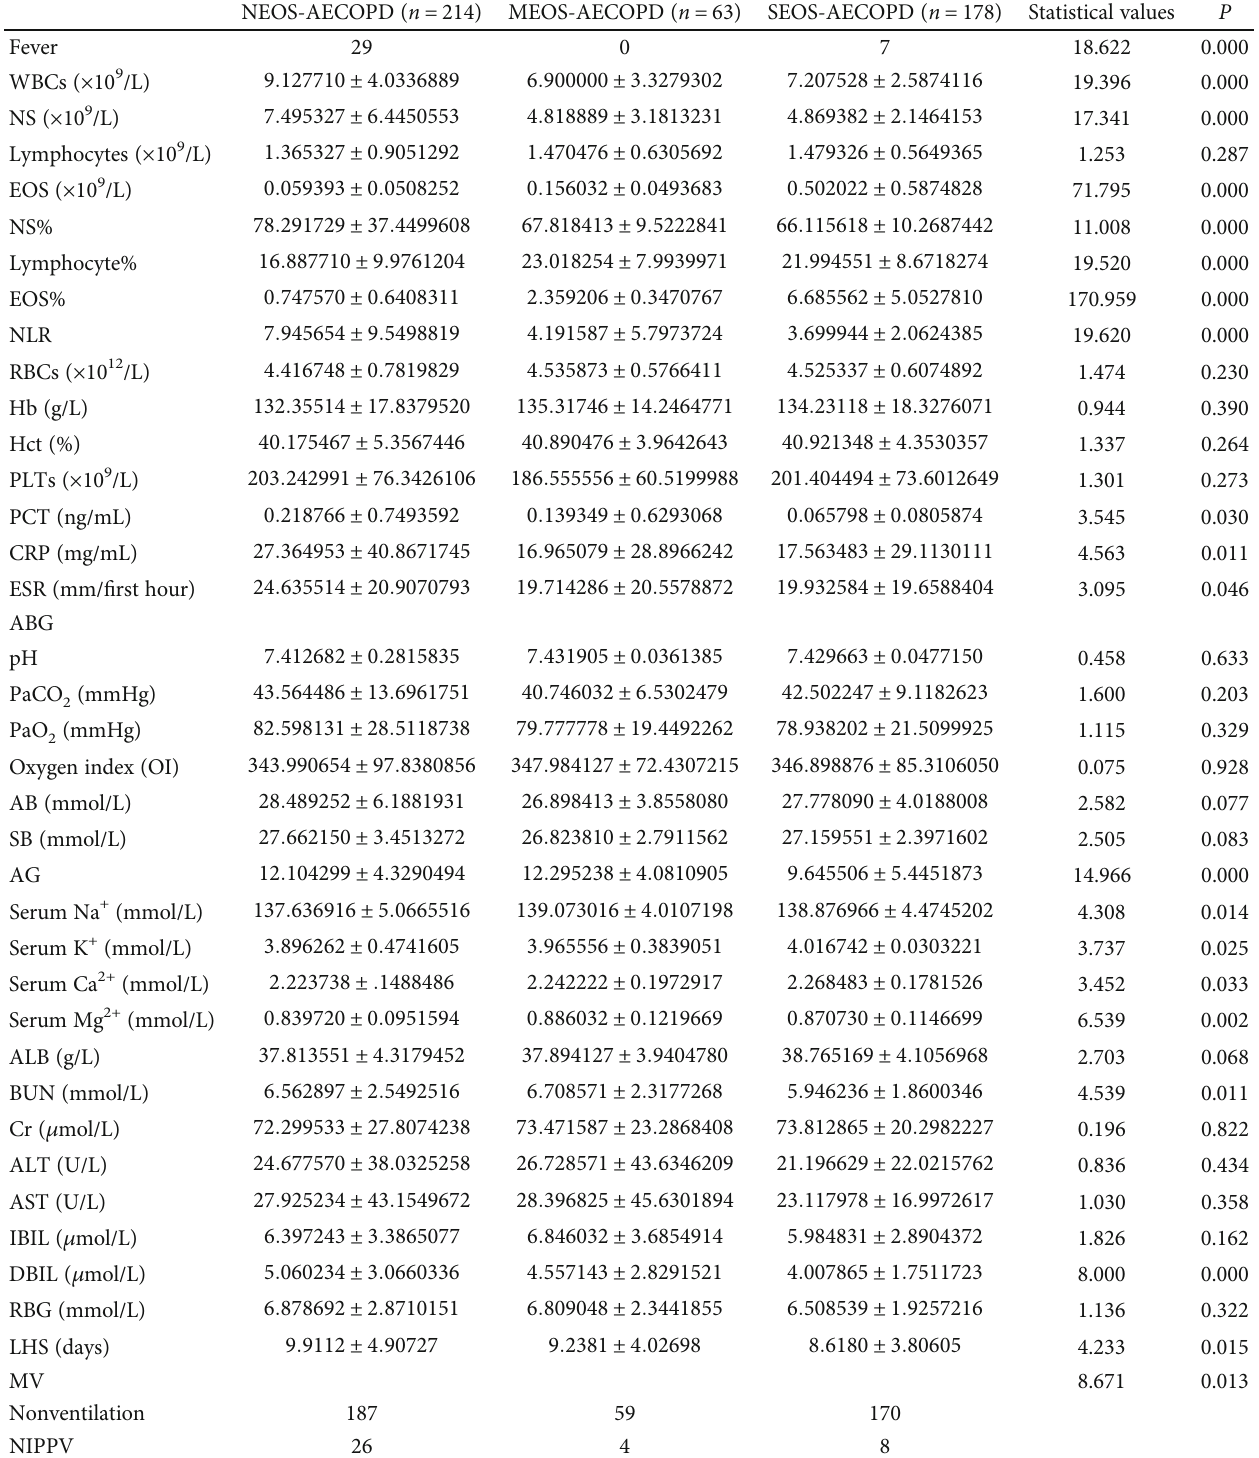
Table 2: Clinical features and laboratory data of the patients with AECOPD ( n = 455